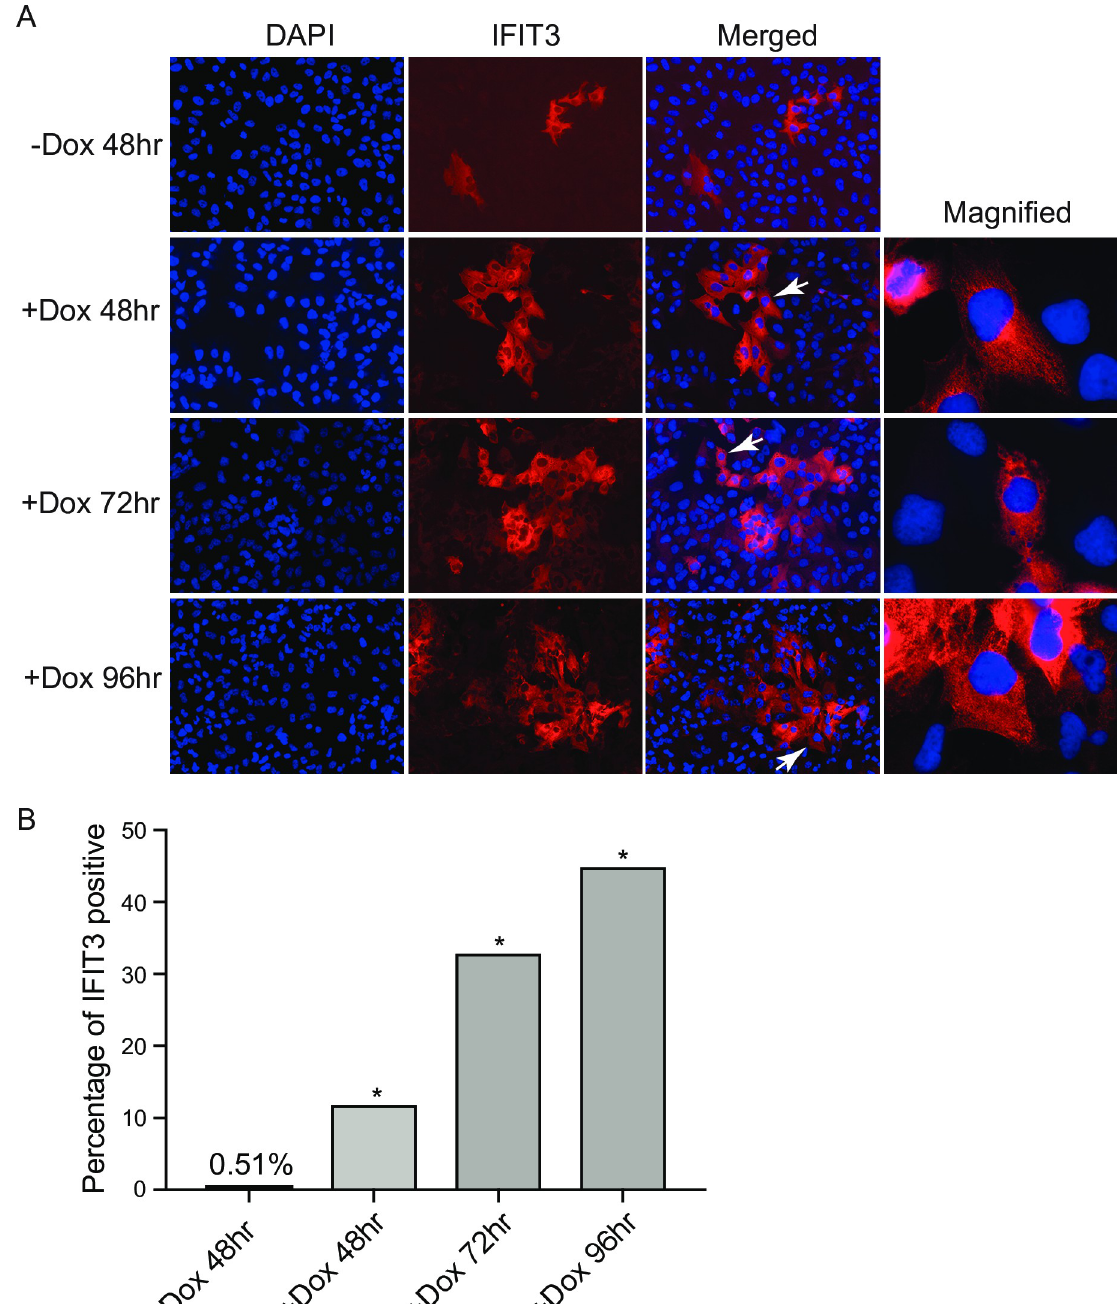
Fig 2. IFIT3 is induced by KSHV lytic replication and localizes to the cytoplasm of infected cells. A. Immunofluorescence microscopy of IFIT3 in KSHV infected cells induced to permit lytic replication. KSHV-infected iSLK cells were untreated (-D) or treated with doxycycline (+D) to induce replication. Cells were fixed at 48hr, 72hr and 96hr post induction (pi) as shown. Cells were then stained for IFIT3 (Red). Arrows indicate magnified cells which are shown at right in each panel. B. Percentages of IFIT3 positive staining cells were counted at different time point post induction (pi) as shown. � P <